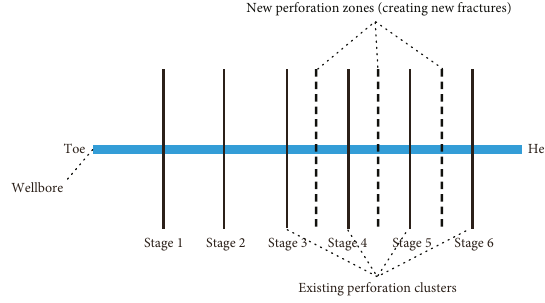
Figure 4: Di ff erent refracturing scenarios: refracturing through the existing perforation clusters and refracturing through new perforation